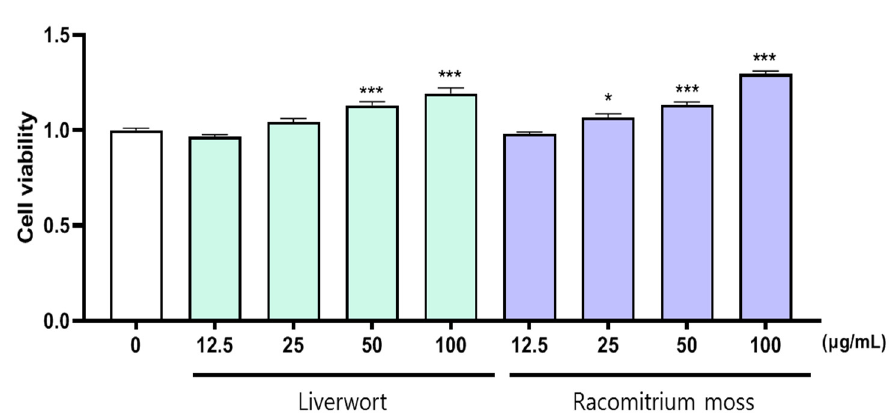
Figure 2. The effect of methanol extract of liverwort and Racomitrium moss on the cell viability of HaCaT cells. Values are mean of three replicate determinations ( n = 3) ± standard deviation. * p < 0.05, *** p < 0.001 vs. 1% MeOH alone.